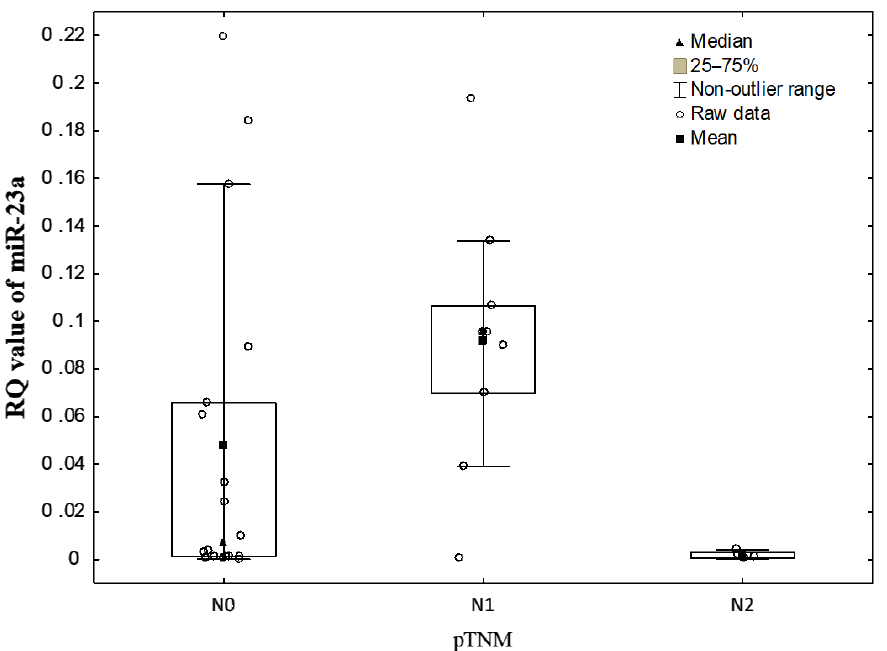
Figure 3. The dot plots representing miR-23a levels (RQ values) in the studied NSCLC groups classified according to the degree of lymph node involvement in pTNM